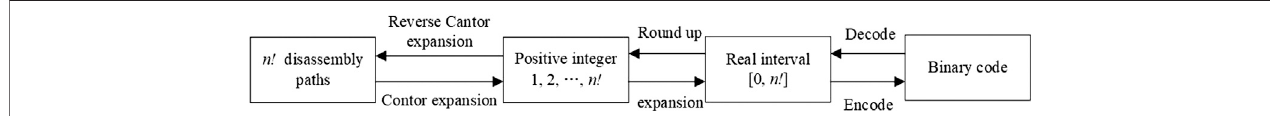
FIGURE 5 | The process of encoding and decoding.